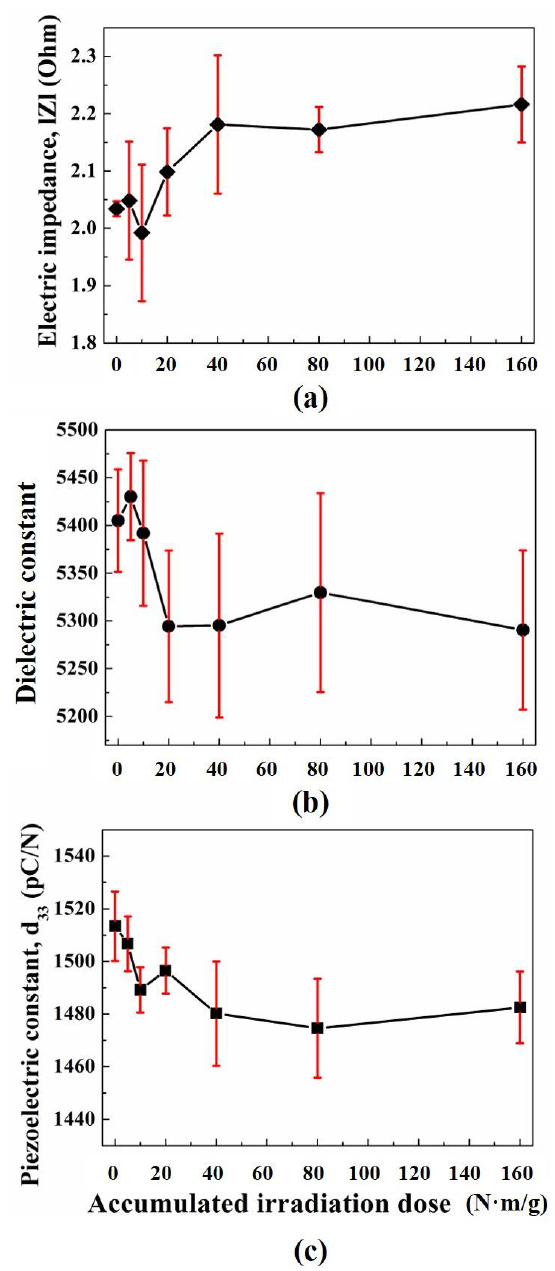
Figure 1. Results of the neutron irradiation effects on three PMN-28%PT samples: ( a ) Electrical impedance, | Z | ; ( b ) dielectric constant, ε r ; ( c ) piezo-electric charge constant, d 33 .